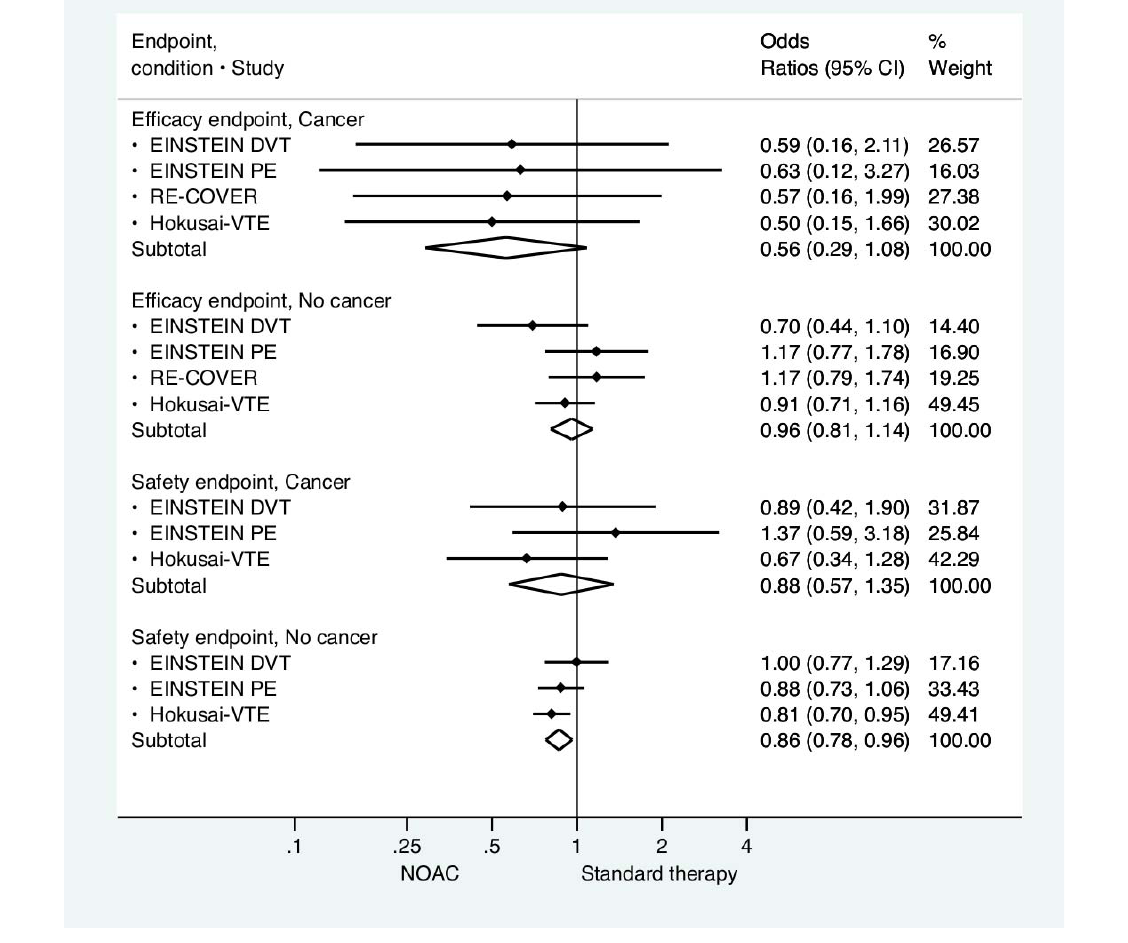
Figure 2. Study level and weighted across study efficacy and safety of non-vitamin K oral anticoagulants in treatment of acute venous thromboembolism in patients with and without cancer. CI: confidence interval. NOAC: Non-vitamin K oral